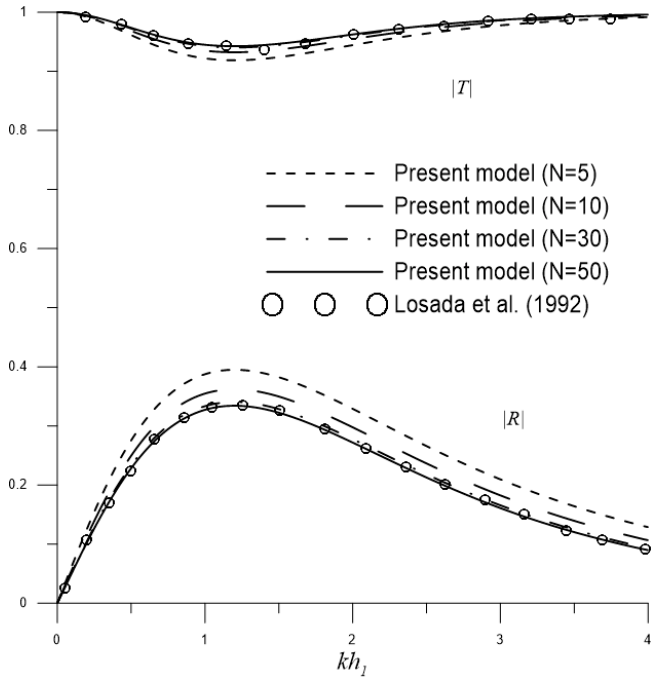
Figure 4. Reflection | R | and transmission | T | coefficients varying against kh 1 for a single bottom- standing barrier over the flat bottom in normally incident waves.